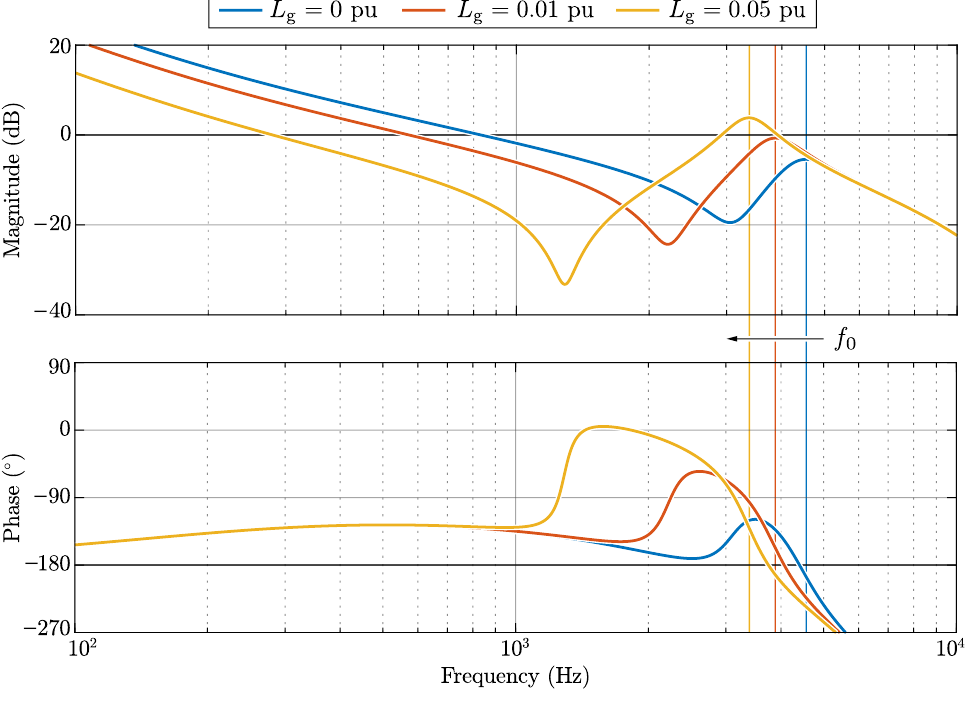
Figure 21. Bode plots of the analytical i d and i q compensated loop gains for different values of grid inductance L g . The PI controllers are tuned according to